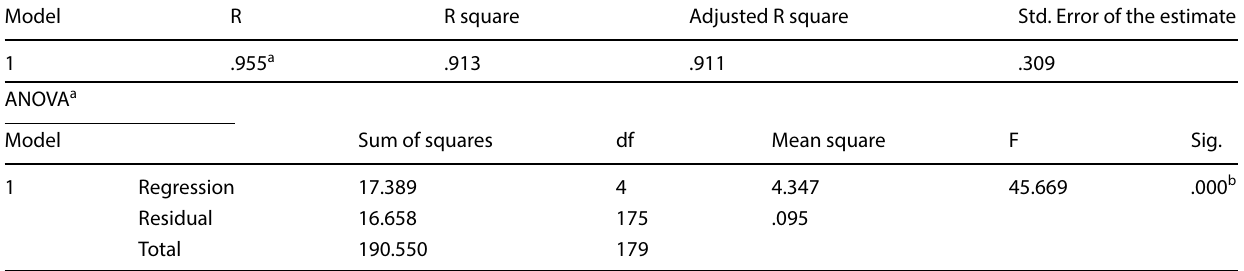
Table 4 Model summary for overall variables